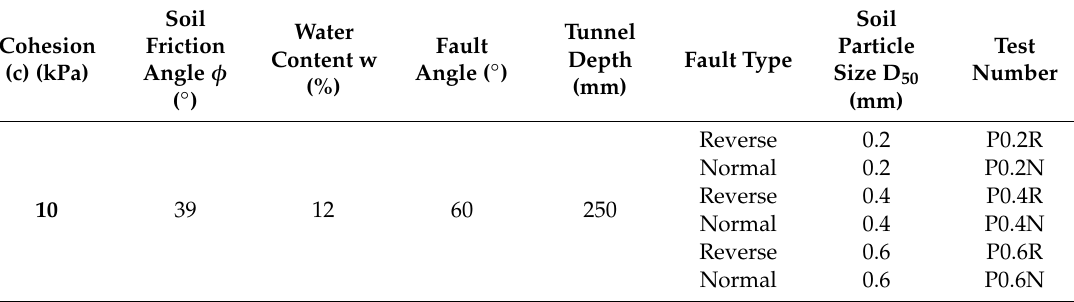
Table 2. Soil properties used for various soil particle size.